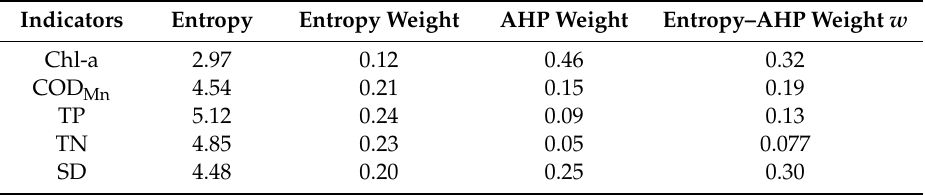
Table 3. Weights of indicators for eutrophication assessment.